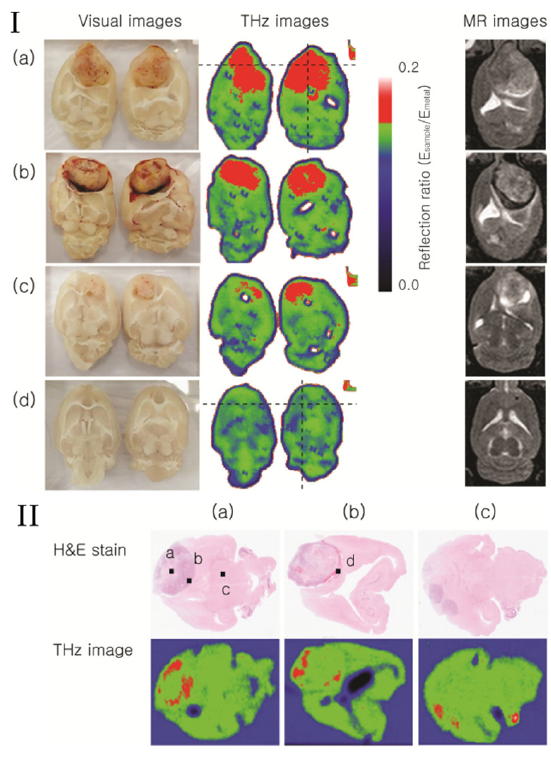
Figure 3. I: Visual, THz, and MR images of whole-brain images with ( a – c ) and without ( d ) tumors. II : Comparison of THz images of three samples ( a – c ) paraffin-embedded whole brain tumors and visual images stained with Hematoxylin and Eosin (H&E). Point a is a microscopic image of the center of the tumor, ( b ) is the outer region of tumor, ( c ) is the normal area ( a ). Point ( d ) is the hemorrhage region ( b ). Adapted from [145].